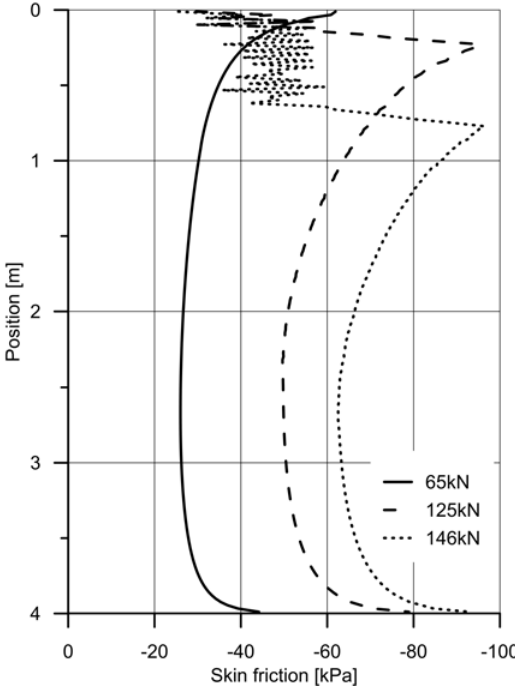
Figure 6. Shear stress distributions for different loading